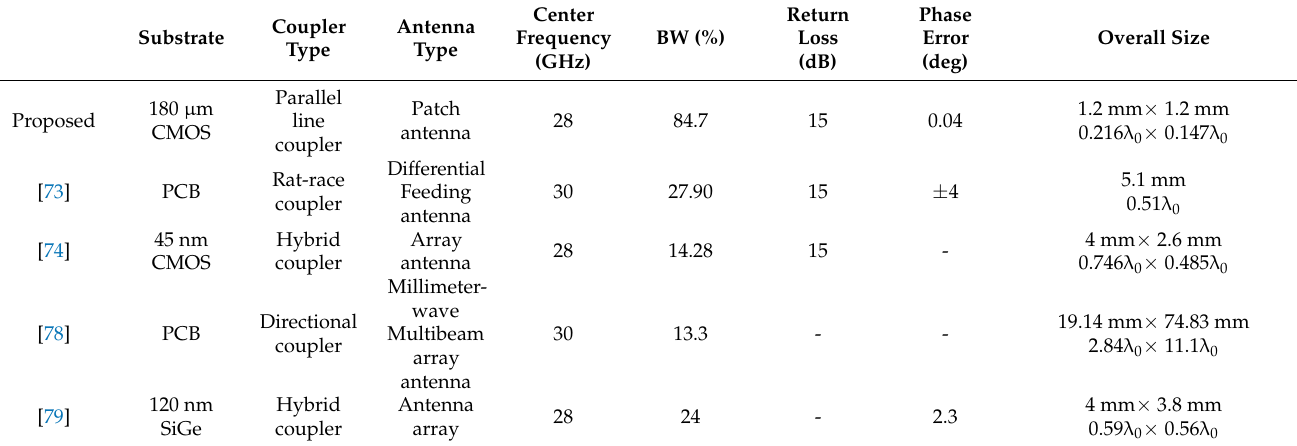
Table 2. Comparison with other antennas.